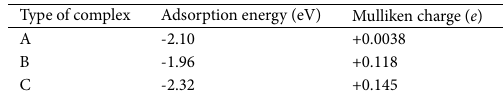
Table 2. Adsorption energy and Mulliken charge values for NO 2 molecule adsorbed on TiO 2 /Gold nanocomposites. Type of complex